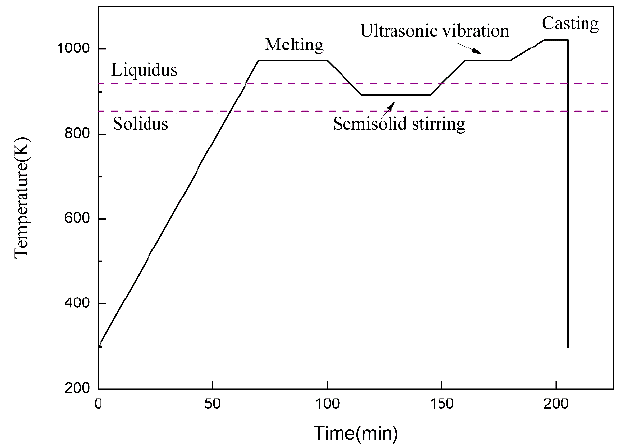
Figure 2. The diagram indicating the temperature–time relationship during casting.